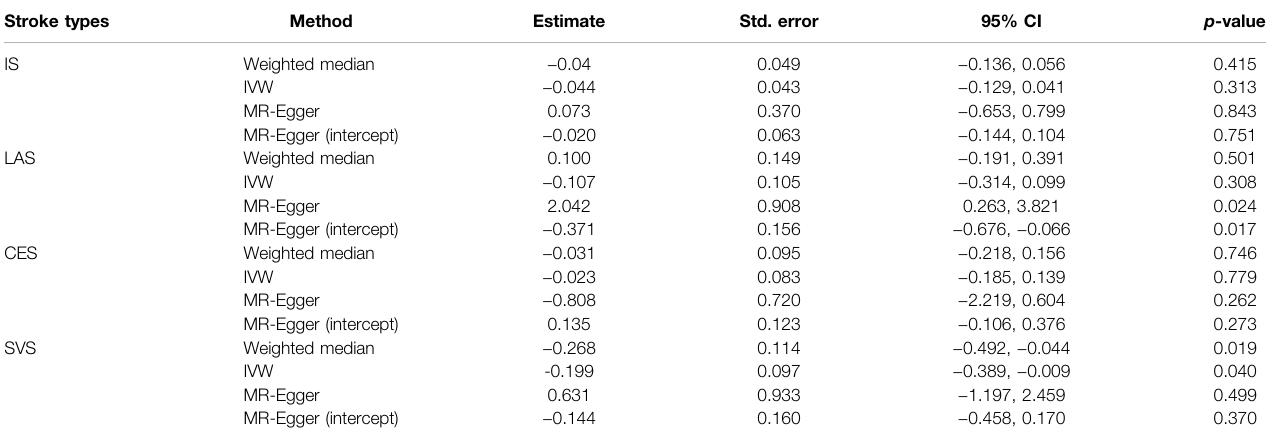
TABLE 3 | MR analysis of association between 3 BNPs (rs198389, rs13107325, rs11105306) and ischemic stroke and its